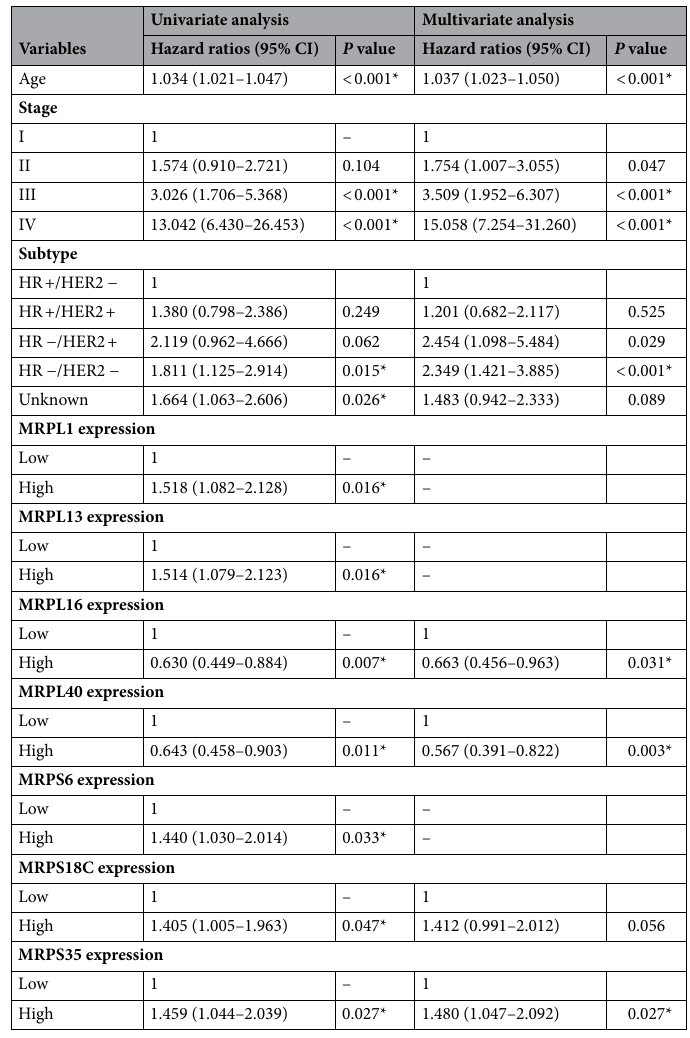
Table 2. Univariate Cox proportional hazards regression analysis in the TCGA patients, and multivariate analysis of the MRP-based nomogram. HR hormone receptor, HER2 human epithelial growth factor receptor, CI confidence intervals. * P value < 0.05, the variable has statistically